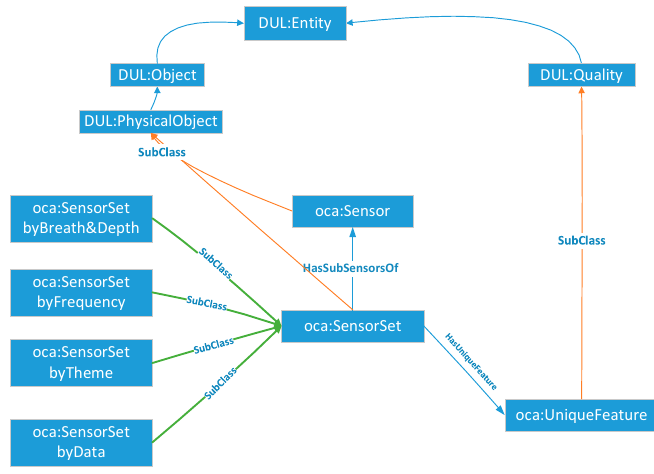
Figure 7. Core classes of the SensorSet module.